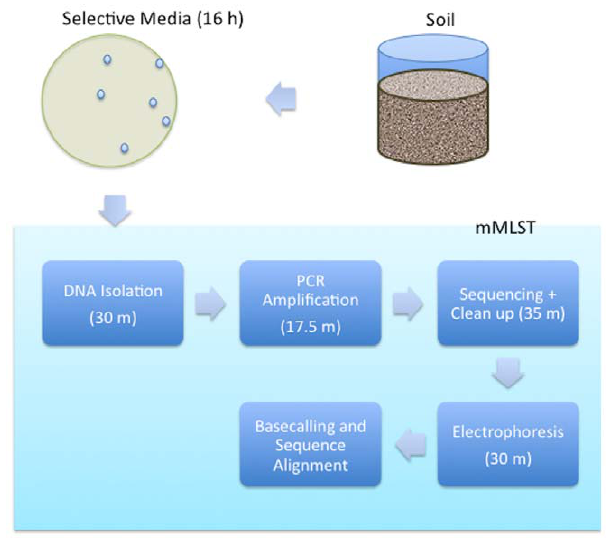
Figure 4. Workflow of mMLST sequencing.